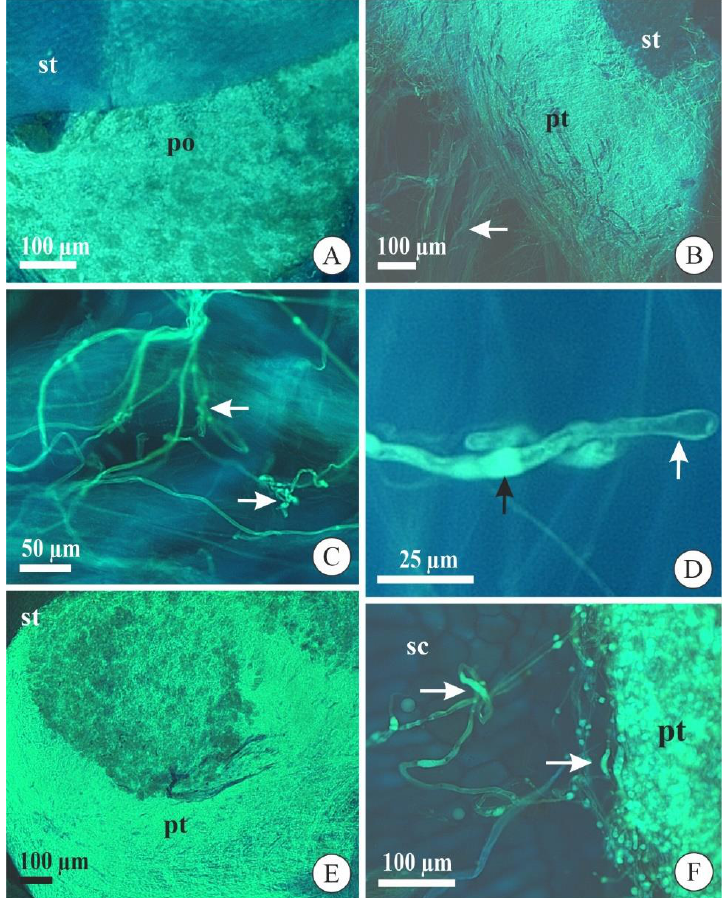
Figure 3. Pollen grain germination and pollen tube growth in flowers and fruits of Acianthera fabiobarrosii ( A , C ) and A. johannensis ( B , D – F ) observed with an epifluorescence microscope after self-pollination. ( A ) Pollinia in the stigmatic cavity (five days after pollination-DAP). ( B ) Pollen tubes (arrow) that stopped growing near the apex of the stylar canal inside the column (7 DAP). ( C ) Pollen tubes with a tortuous appearance (arrows) stopped growing in the column (7 DAP). ( D ) Detail of the incompatible pollen tube in the column. Observe the callose plug (black arrow) and the dilated tip (white arrow). ( E ) Pollen tubes in a withered self-pollinated flower from a partially incompatible individual (7 DAP). Note the synchronous growth of pollen tubes in the stylar canal. ( F ) Pollen tubes with regular morphology in mature fruit (90 DAP). Observe some pollen tubes with irregular patterns (arrows). po, pollinia. pt, pollen tube. sc, seed chamber. st, stigmatic